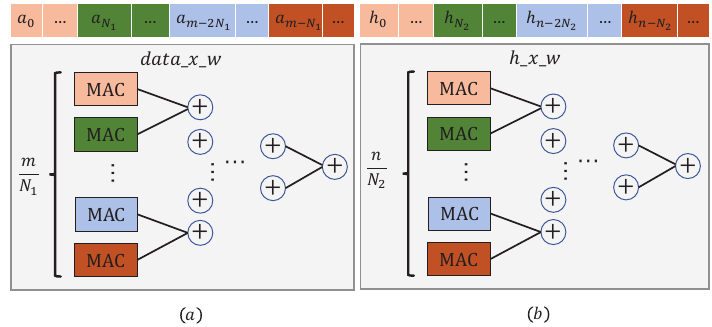
Figure 12. The processing flow of ( a ) Module data _ x _ w ; ( b ) Module h _ x _ w .